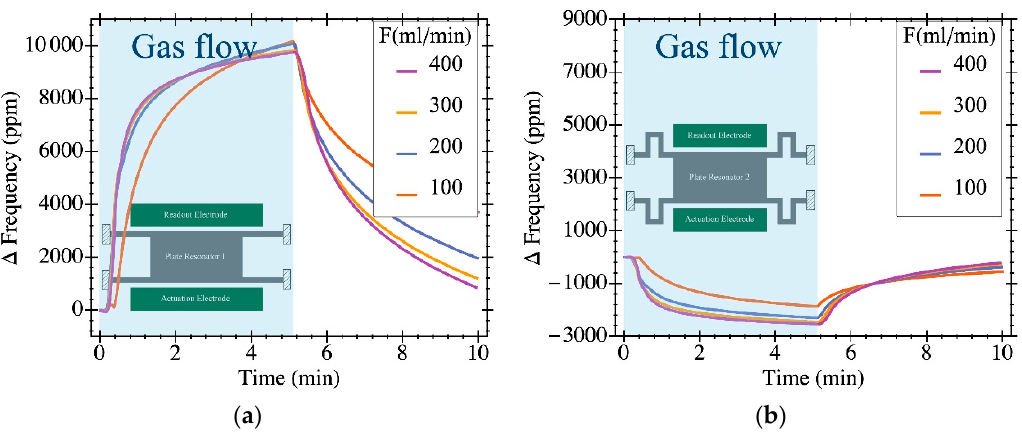
Figure 6. Relative frequency changes over time for a valve aperture and subsequent closure at different gas flow rates (see legend). Each of the resonators exhibits a singular response as a consequence of their different anchor geometries: ( a ) PR1 presents a much larger frequency variation, as high a 10,000 ppm, due to its clamped ends; ( b ) PR2, shows a much smaller absolute frequency change (2500 ppm) thanks to the folded flexure anchors that provide free movement along the y -axis; moreover, its frequency variation takes the opposite direction than for PR1.